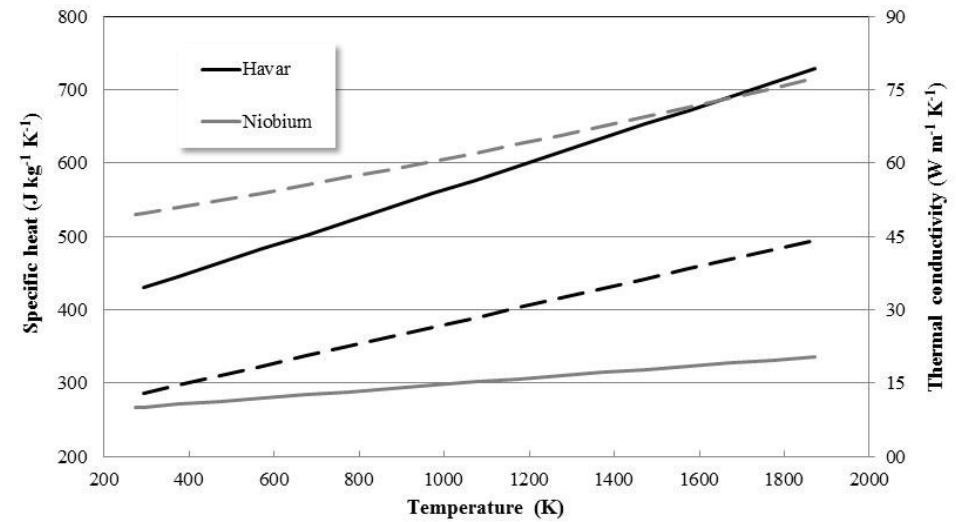
Figure 3. Specific heat (full lines) and thermal conductivity (dash lines) of havar (black lines) and niobium (grey lines) as a function of the temperature.